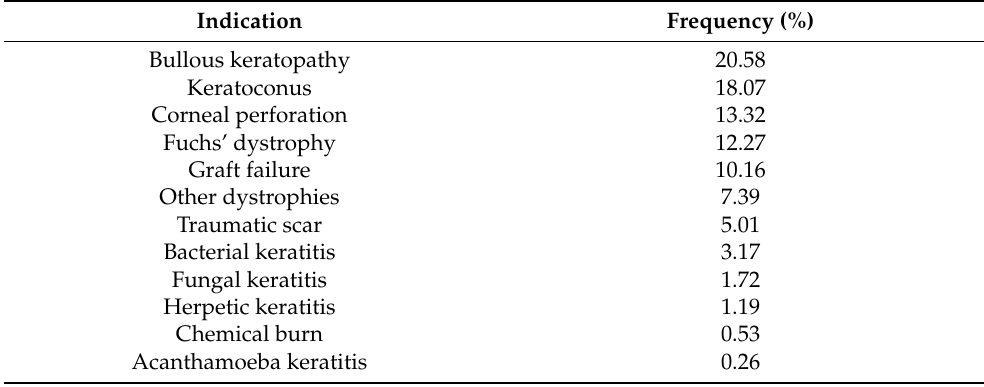
Table 1. Indications for keratoplasty in the studied group.